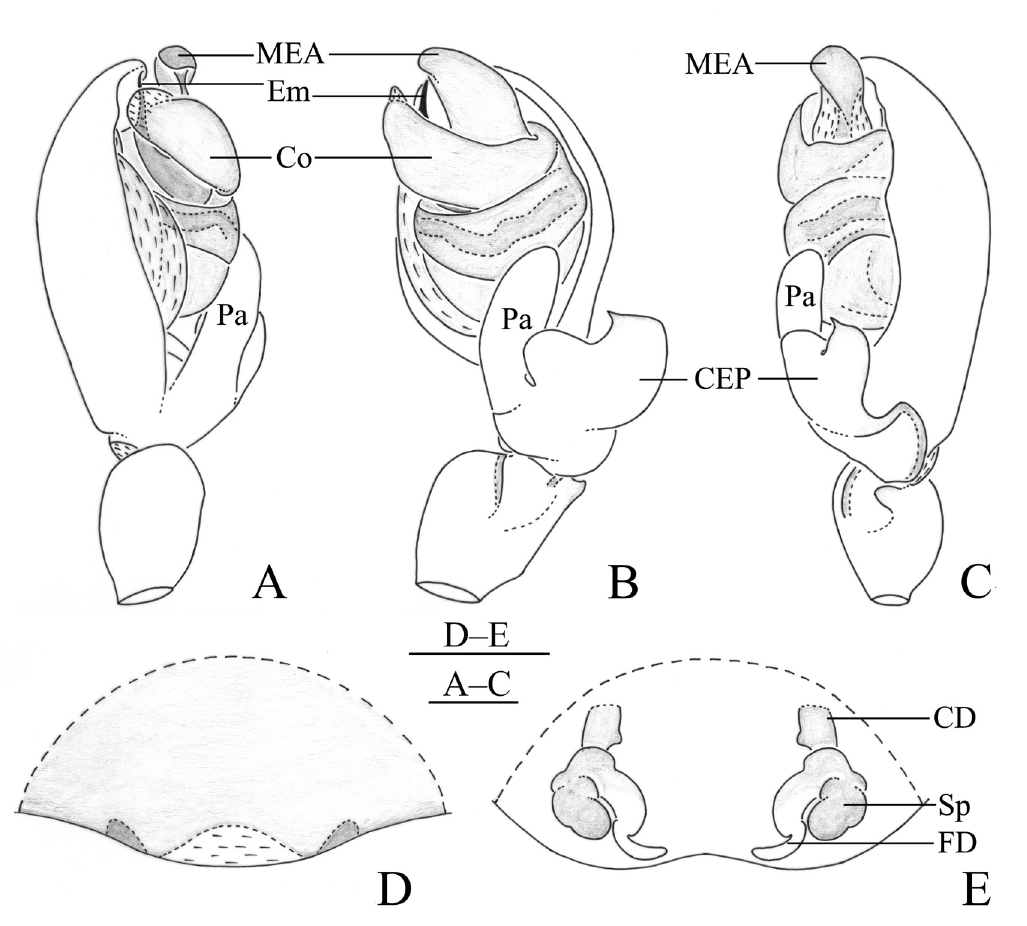
Fig. 15. Meta yinae sp. nov. Left palp of holotype ♂ (A–C); epigyne (D) and vulva (E) of paratype ♀ (HNU-Tang-05-08). A . Prolateral view. B . Ventral view. C . Retrolateral view. D . Epigyne, ventral view. E . Vulva, front view. Scale bars: 0.2